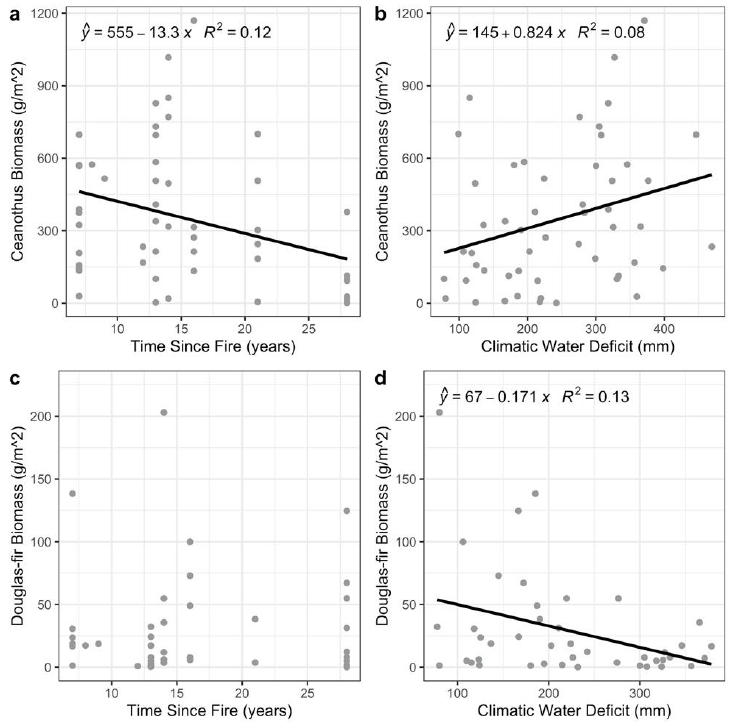
Figure 3. Linear regressions of Ceanothus spp. and Douglas-fir biomass with time since fire ( a , c ), and climatic water deficit ( b , d ). Black regression lines demonstrate significant relationships ( p < 0.05). 3.2. Soil Resources (C and N) There were no significant relationships between soil biogeochemical variables (soil C, N, and C:N) and time since fire (Figure 4a – c). Soil N values did not vary significantly with climatic water deficit (Figure 4e). However, soil C and C:N ratio both decreased sig- nificantly with climatic water deficit (Figure 4d,f; p = 0.02 and 0.002).